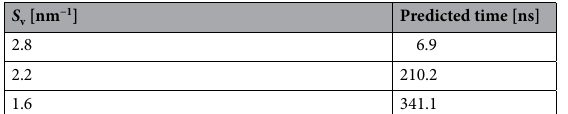
Table 2. Predicted time to achieve a completely dense structure calculated using the fitted line from the relative density